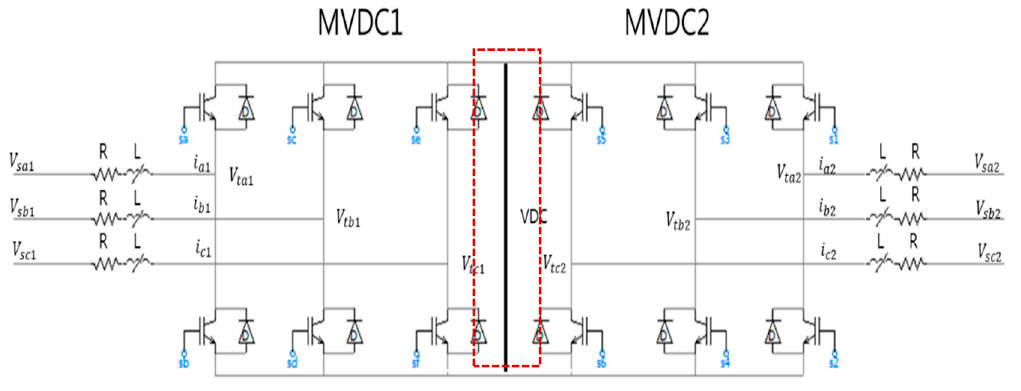
Figure 5. Circuit diagram of the proposed MVDC system .